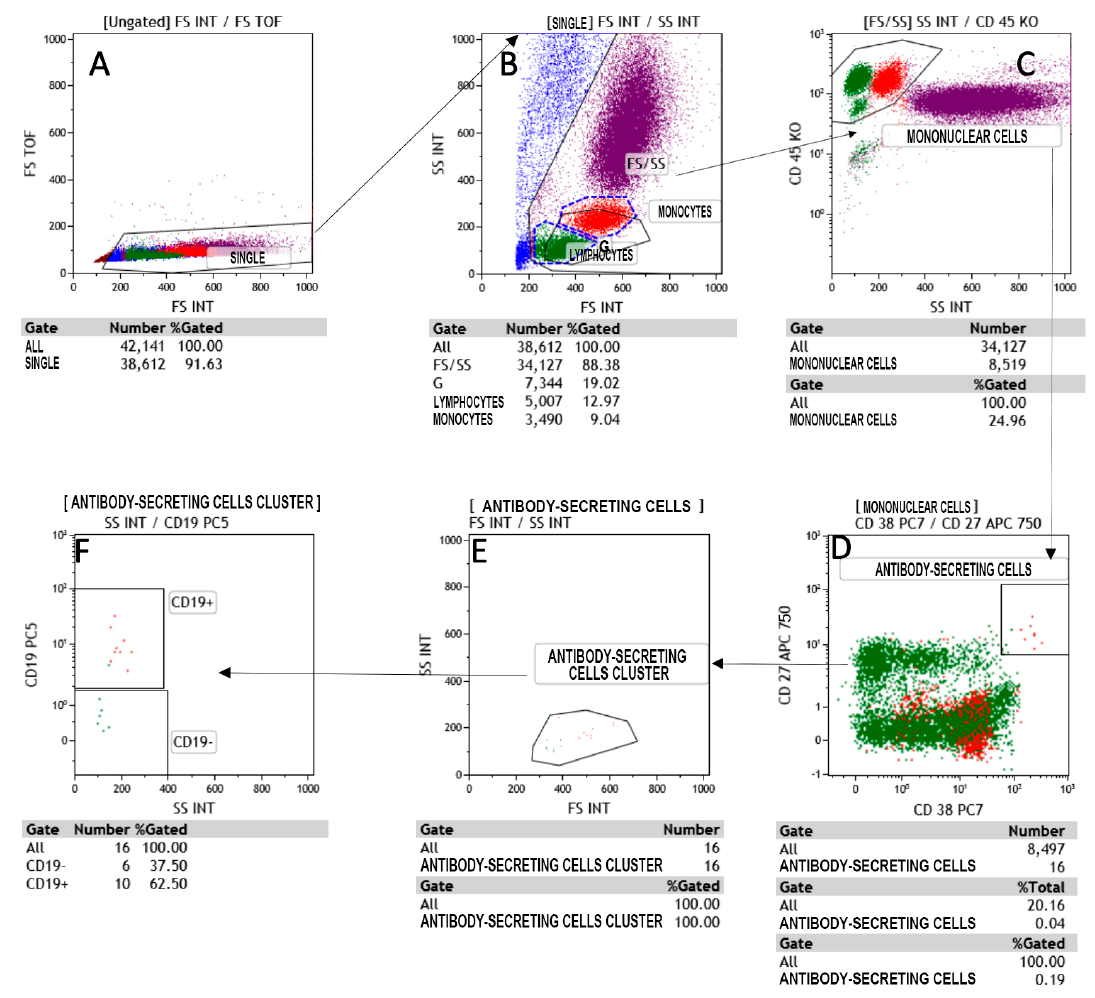
Figure 1. Flow cytometry gating strategy to identify the antibody-secreting cells (ASC) in Covid-19 patients. ( A ) The dot plot A shows the region SINGLETS; ( B ) dot plot B gated on SINGLETS region display physical characteristic FS vs SS in which we are drawn lymphocytes and monocytes region, ( C ) in dot plot C gated by FS/SS region the intersection between CD45 vs SS identify the Mononuclear cells gate; ( D ) the antibody secreting cells (ASC) shown in dot plot D, are gated by mononuclear cells. Finally; ( E , F ) in E and F the cell cluster and the CD19 expression are respectively